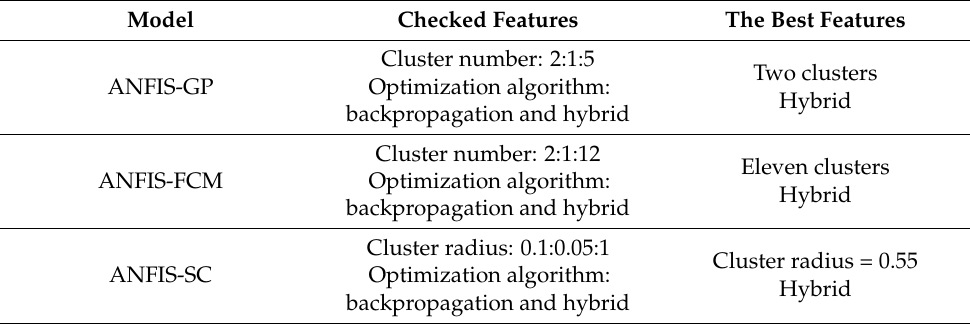
Table 2. The checked and selected structural features of different ANFIS